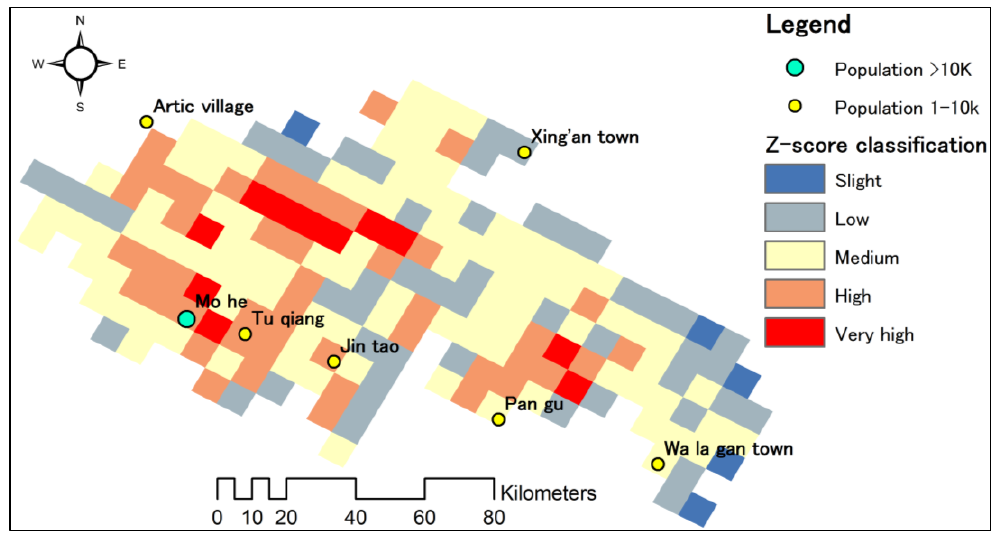
Figure 3. The fire damage of the entire burned area divided into five classes: Very high (VH), High (H), Moderate (M), Low (L) and Slight